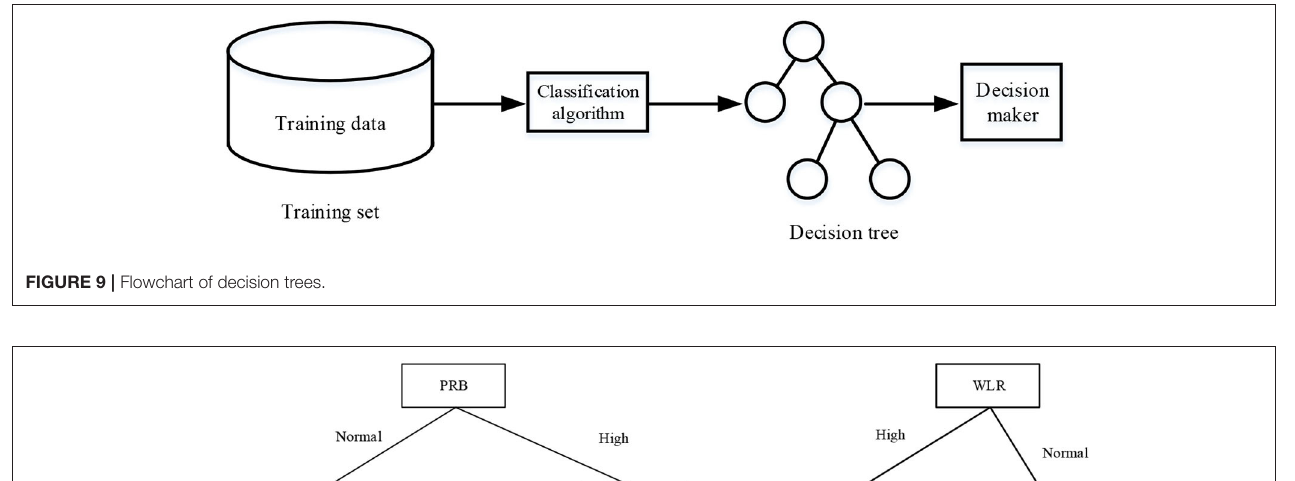
Frontiers in Energy Research |